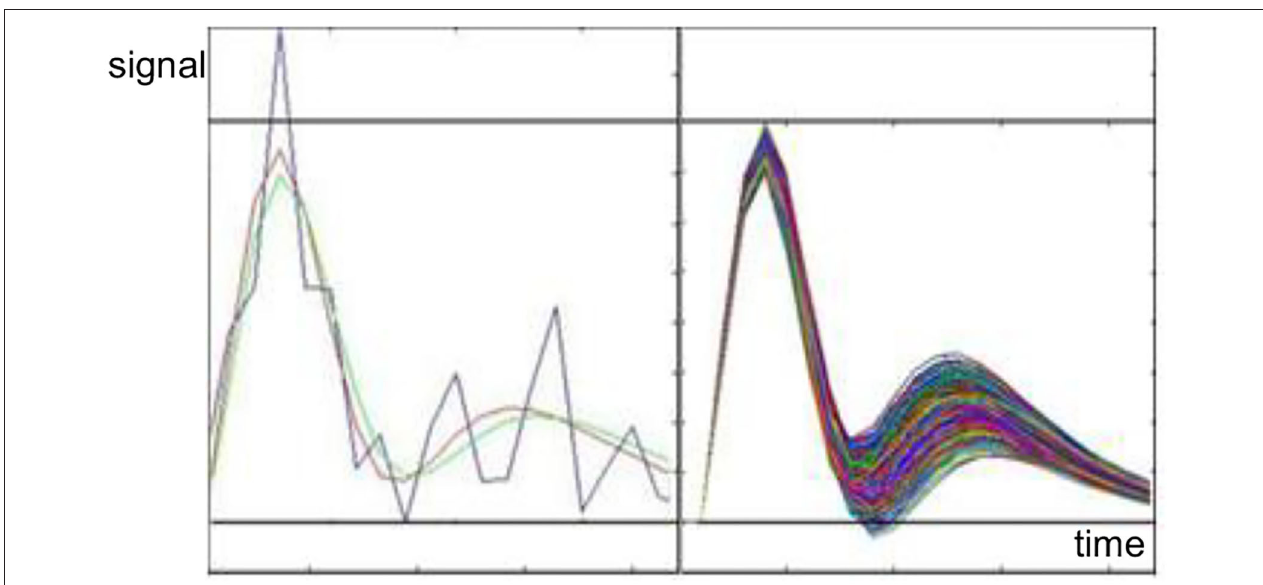
FIGURE 5 | Left: An example of hemodynamic response function (HRF) (black) fitting using Glover transform (GT) (violet) and Levenberg–Marquardt Algorithm (LMA) (green). Right: Inverse GT for different measures (color code in the